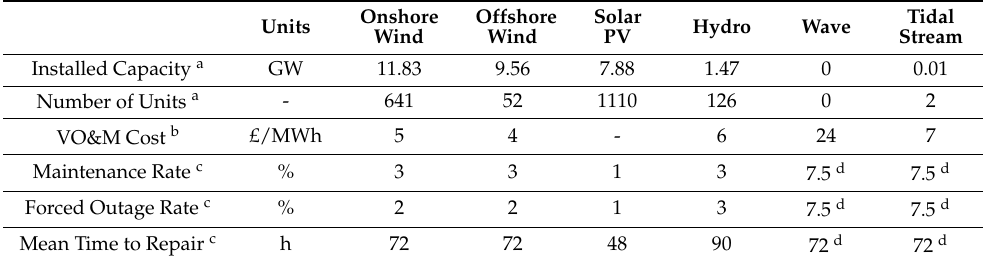
Table 2. Renewable generation techno-economic characteristics used in the model, with the source given in the first column unless otherwise noted in each